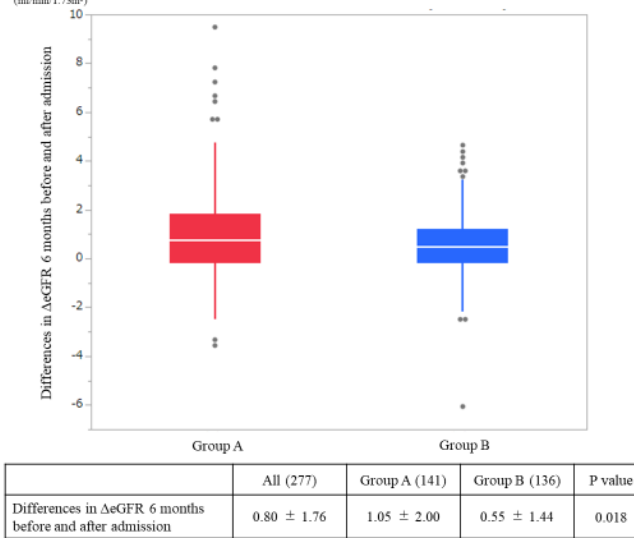
Figure 2. Di ff erences in the estimated glomerular filtration rates ( ∆ eGFR) on admission and at six months after admission. The p -values were statistically analyzed by a Student’s t